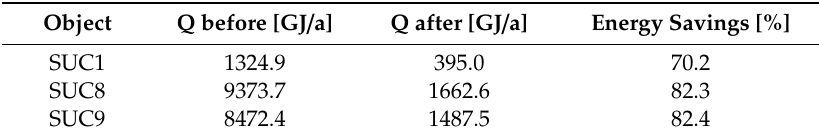
Table 7. Heat consumption values before and after thermo-modernization according to energy audits (theoretical